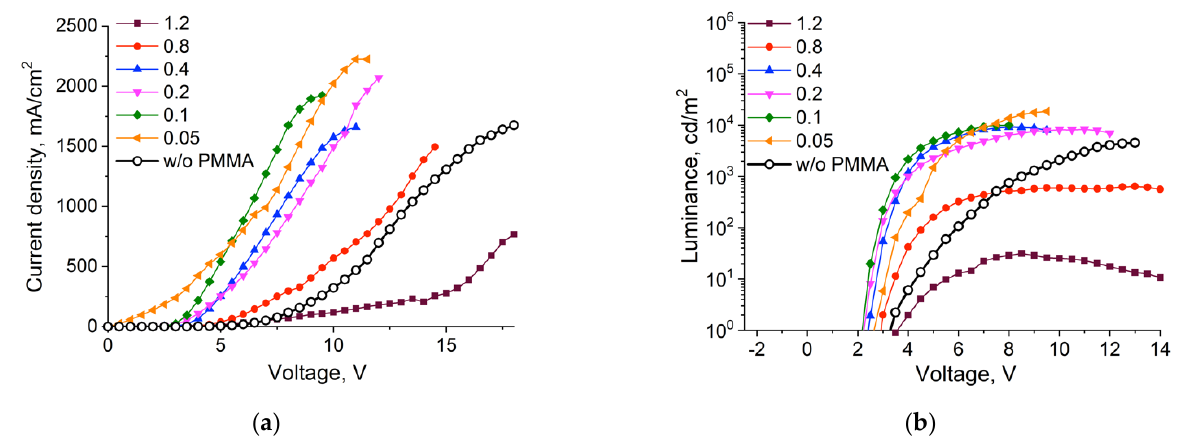
Figure 2. Current density ( a ) and luminance ( b ) versus voltage characteristics of QDLED samples employing a PMMA EBL deposited from PMMA solutions in acetone with different concentrations.